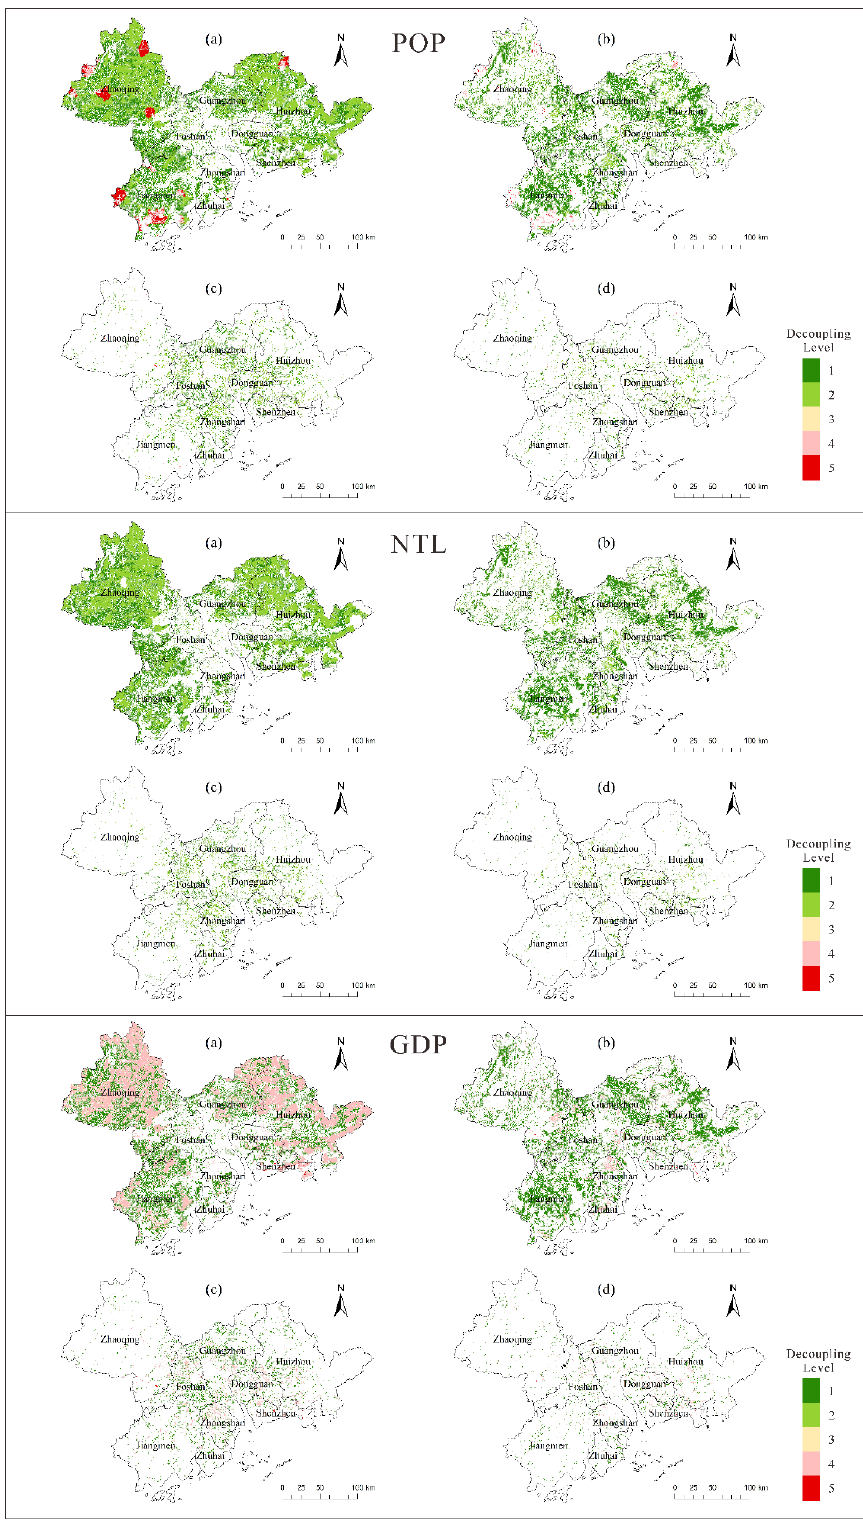
Figure 8. Decoupling between socioeconomic factors (POP, NTL, and GDP) and net primary productivity (NPP) in ( a ) V c , ( b ) V c + h , ( c ) V nu , and ( d ) V pu